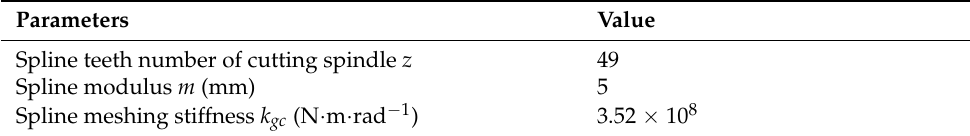
Table 1. Parameters of the cutting mechanism rotor system of